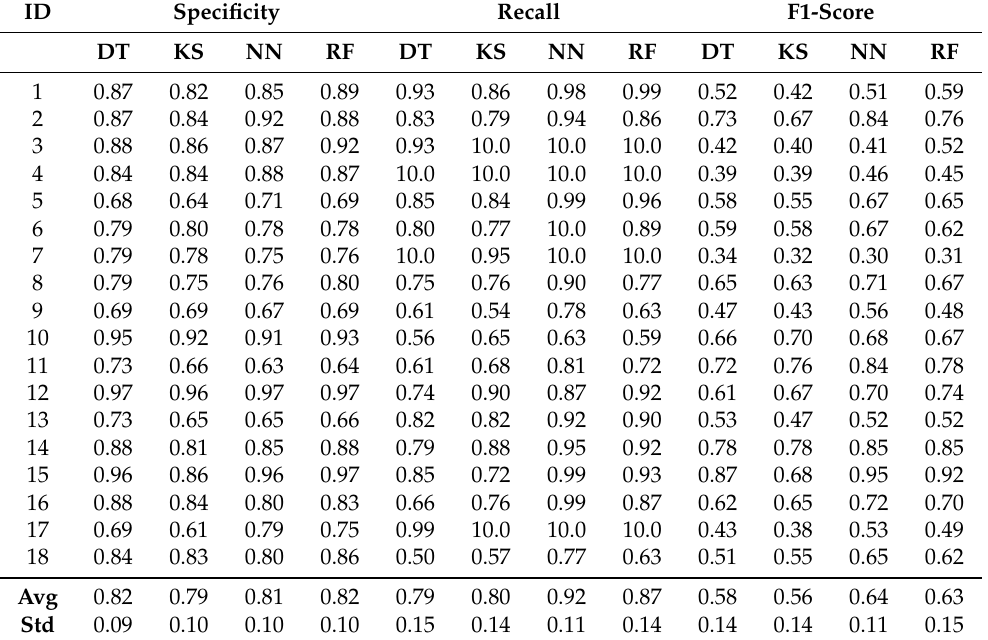
Table 4. Classification results by algorithms using 6 features.